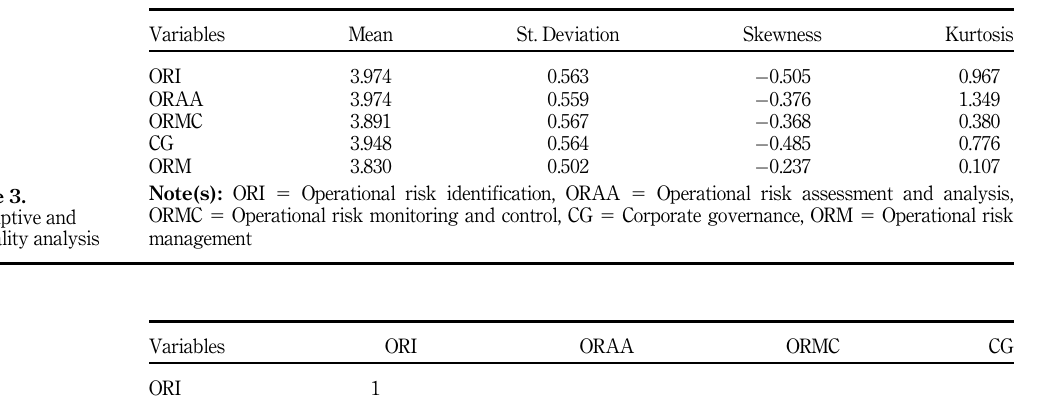
Table 2. Demographic analysis